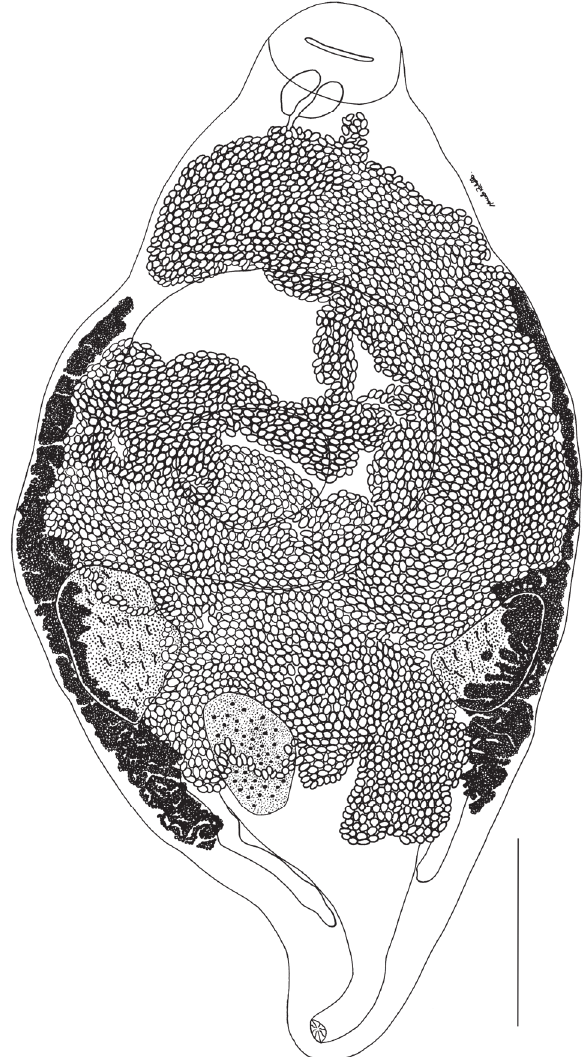
Figure 2. Specimen of Canaania obesa , ventral